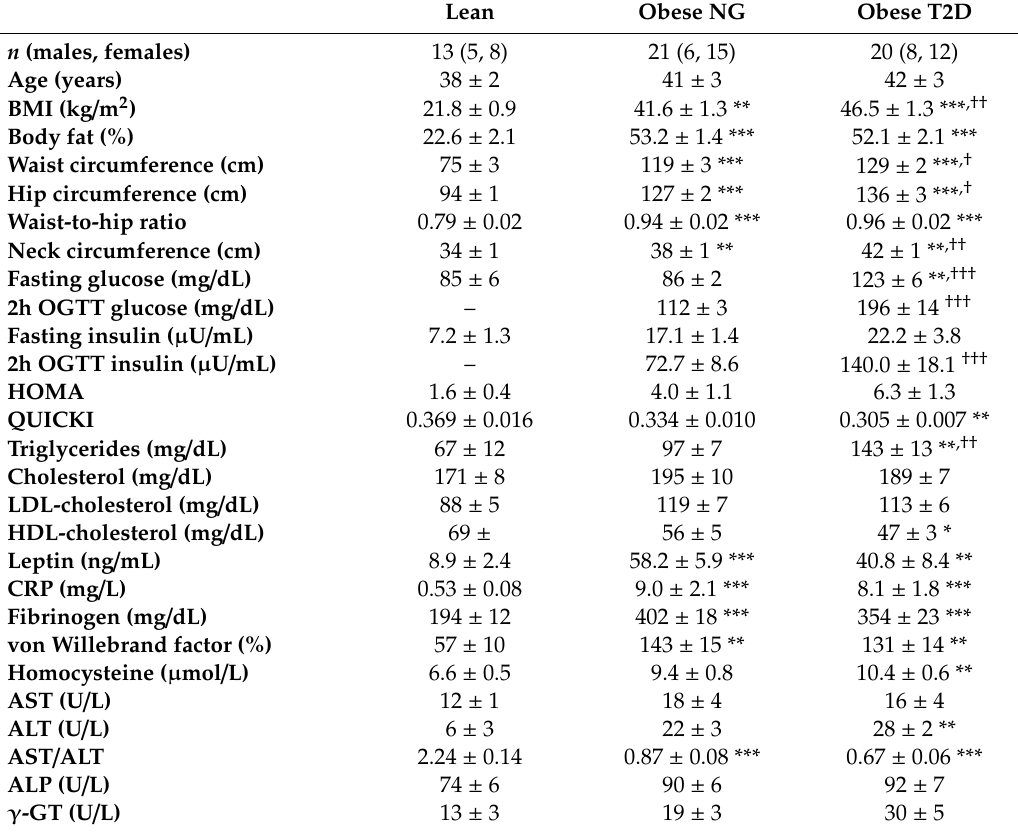
Table 1. Anthropometric and biochemical characteristics of subjects included in the study. Lean Obese NG Obese T2D n (males,